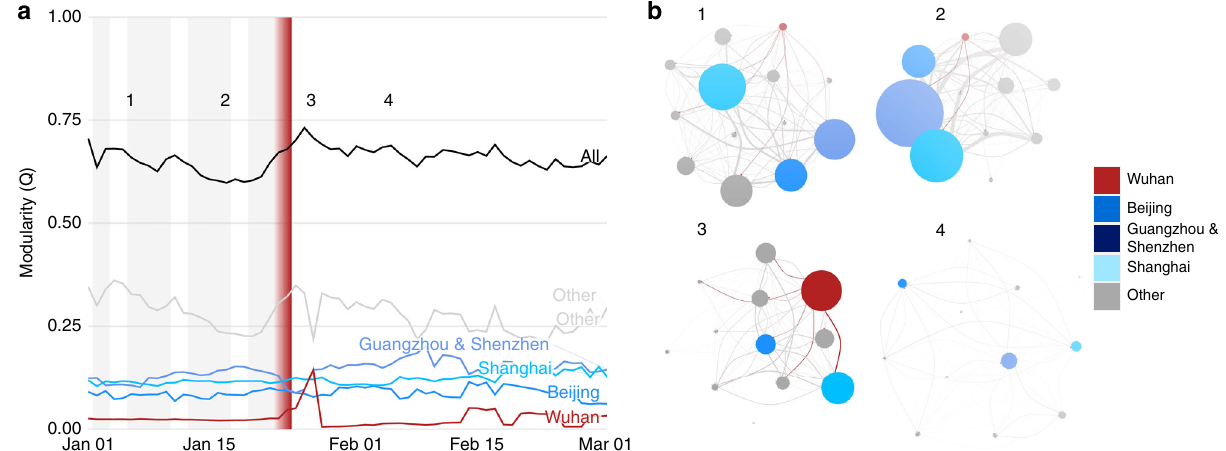
Fig. 4 Community structure of the movement network. Community structure is measured through modularity, a metric de fi ning the strength of connections within vs. between communities. The members of communities are determined by the Leiden algorithm 20 . a The time series of total and sub- community modularity, and ( b ) snapshots of the community networks on days before and after the cordon sanitaire . The communities for Wuhan (red) and several major cities (blues) are highlighted in a and b in both the community and edges between communities. The time series shows working week (grey bars; missing after nation-wide social distancing measures), as well as the initiation and enforcement of restrictions in Wuhan (red gradient) over 23rd to 24th January. The communities (circles) are sized according to within-community migration index, while their connections are sized according to their between-community migration